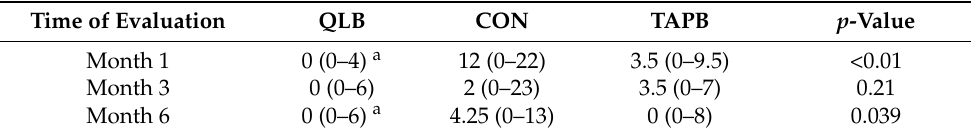
Table 4. Persistent pain severity.